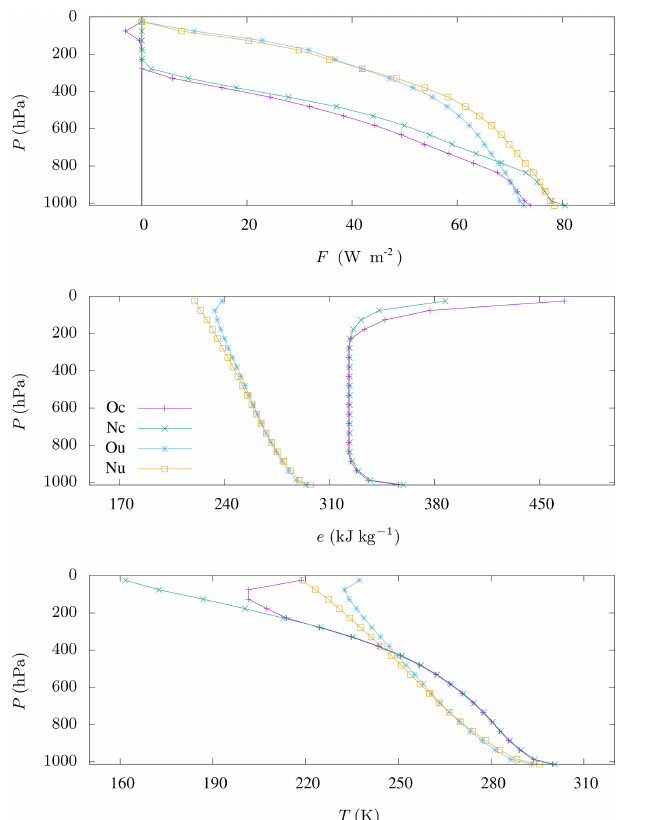
Figure 5. Energy flux F , specific energy e , and temperature T , with and without ozone, for the constrained model with e = C p T + gz + Lq s and for the unconstrained model and for tropical atmospheric composition by McClatchey et al. (1972). Oc: with O 3 , constrained. Nc: without O 3 , constrained. Ou: with O 3 , unconstrained. Nu: with- out O 3 ,